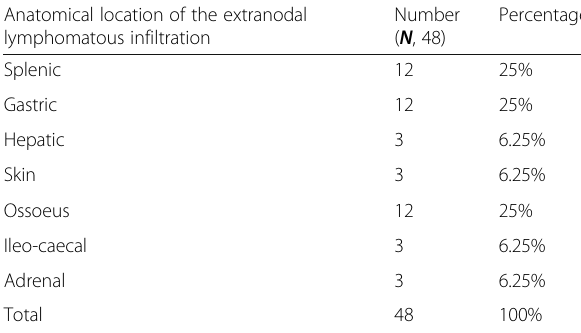
Table 1 Anatomical distribution of the extras nodal lymphomatous lesions (nine patients showing two extranodal lymphomatous locations) Anatomical location of the extranodal lymphomatous infiltration